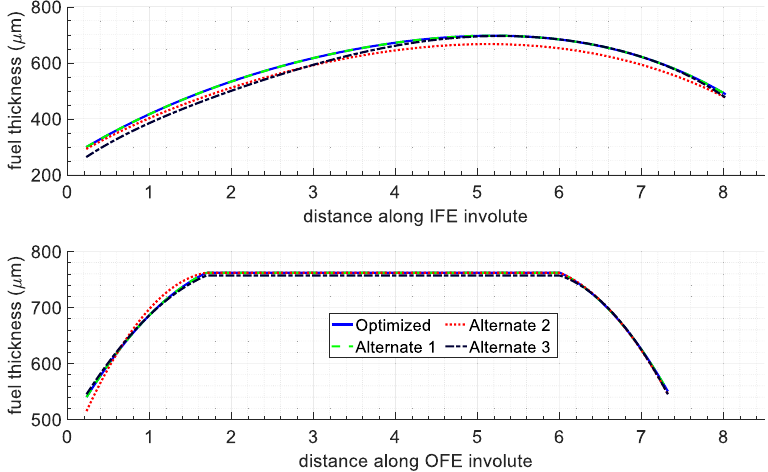
Figure 4. Conceptual design fuel thickness